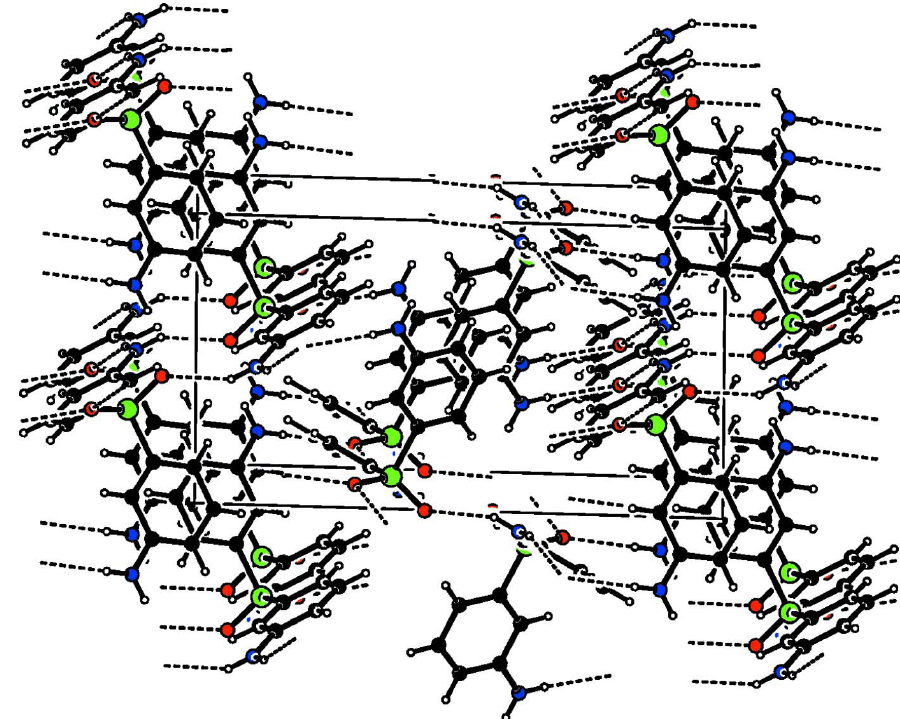
Figure 2 A partial packing diagram of the title compound. Hydrogen bonds are shown as dashed